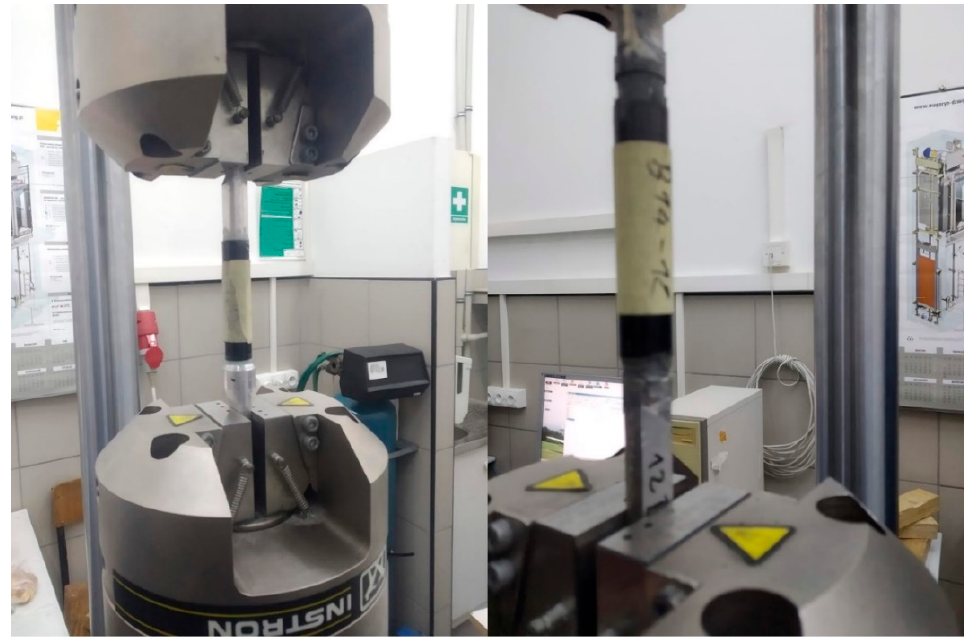
Figure 3. Test setup.